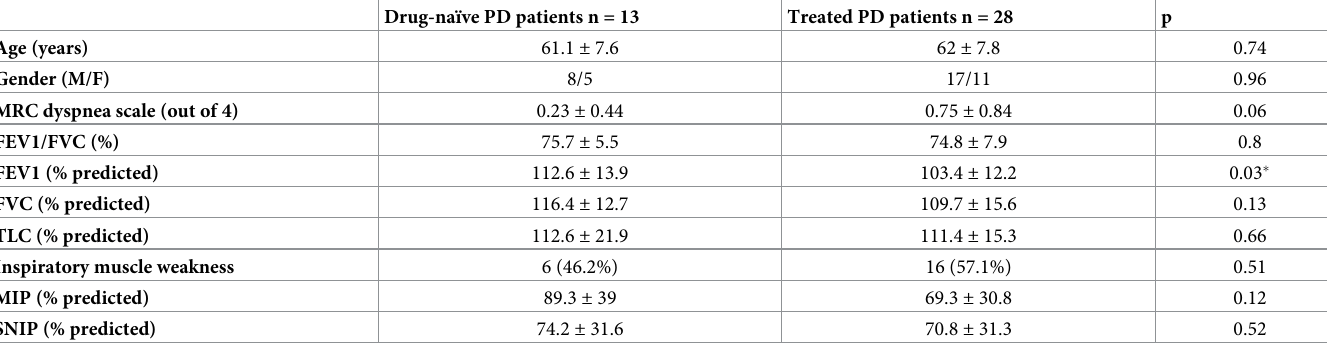
Table 2. A comparison between drug-naïve and treated PD patients.